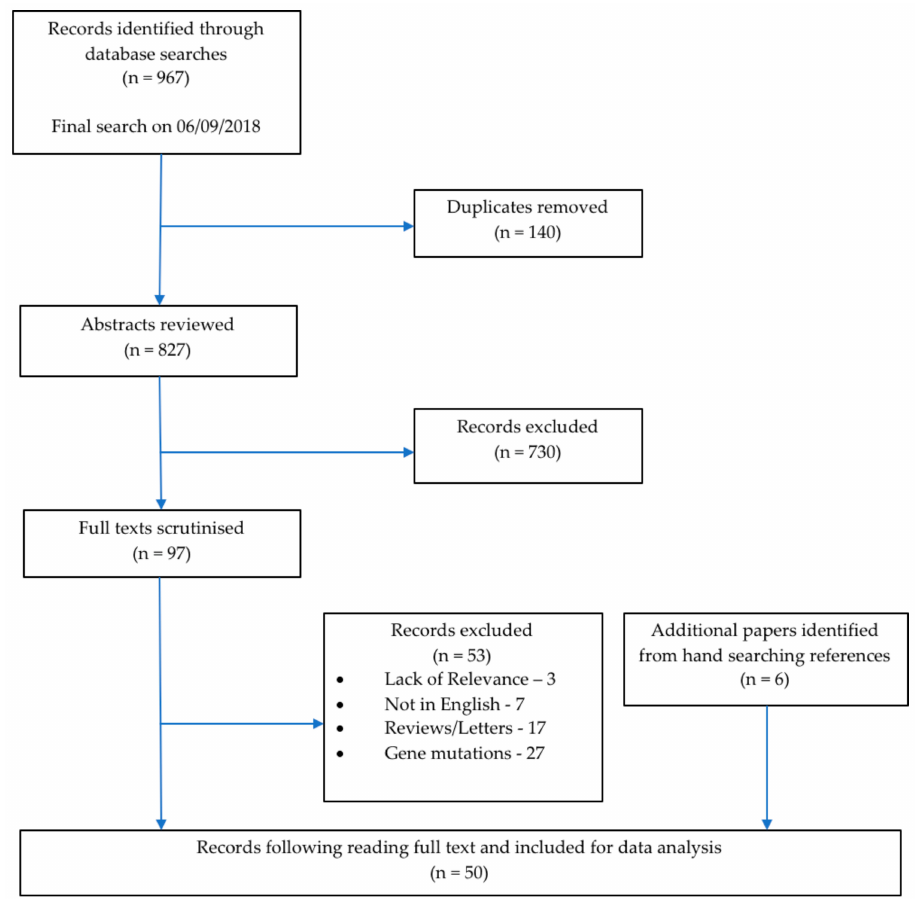
Figure 1. Prisma flow chart illustrating the search strategy and the selection